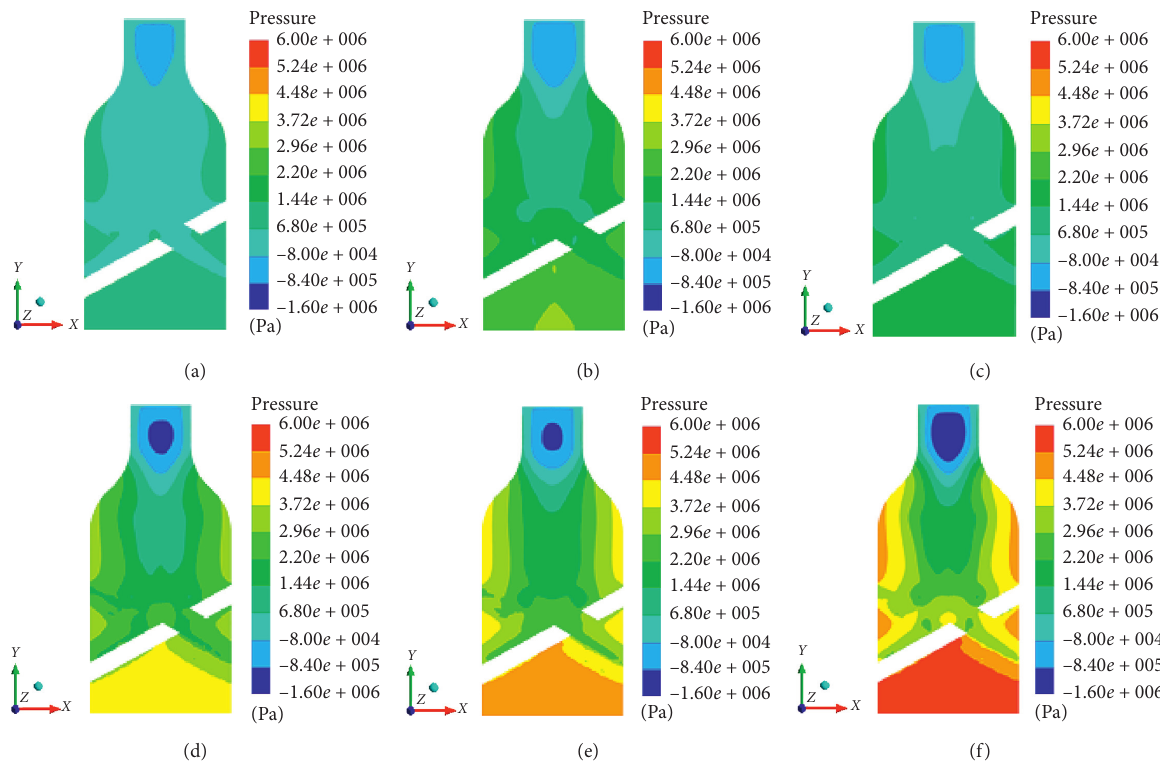
Figure 4: Pressure distribution in the central section of the swirl nozzle: (a) 1MPa, (b) 2MPa, (c) 3MPa, (d) 4MPa, (e) 5MPa, and (f)